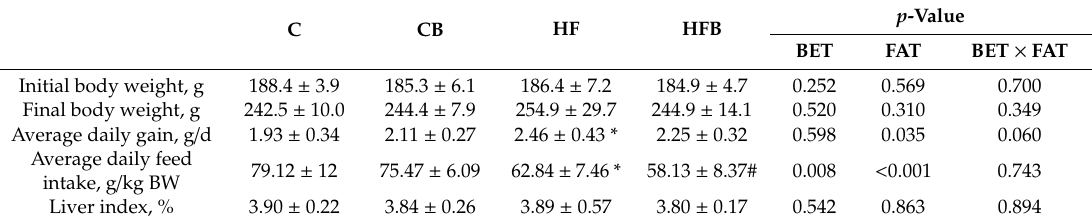
Figure 1. Effects of betaine and high-fat diet on body weight growing on rats ( n = 8). C—basal diet, CB—basal diet supplemented with 1% betaine, HF—high-fat diet, HFB—high-fat diet supplemented with 1% betaine. Table 3. Effects of betaine on growth performance of high-fat-diet-fed SD rats ( n = 8).